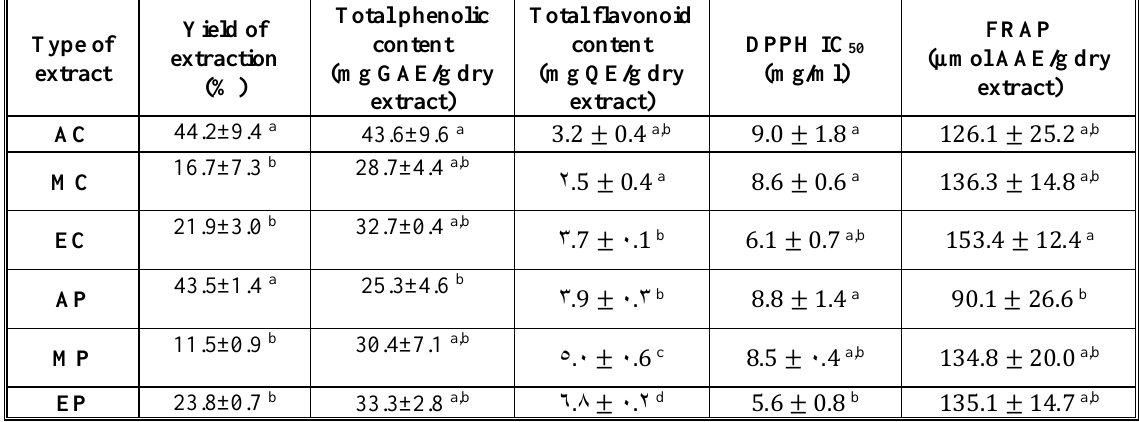
Table 2. Yields of extraction, phenolic and flavonoid contents, and antioxidant activities of Terfezia claveryi and Tirmania pinoyi